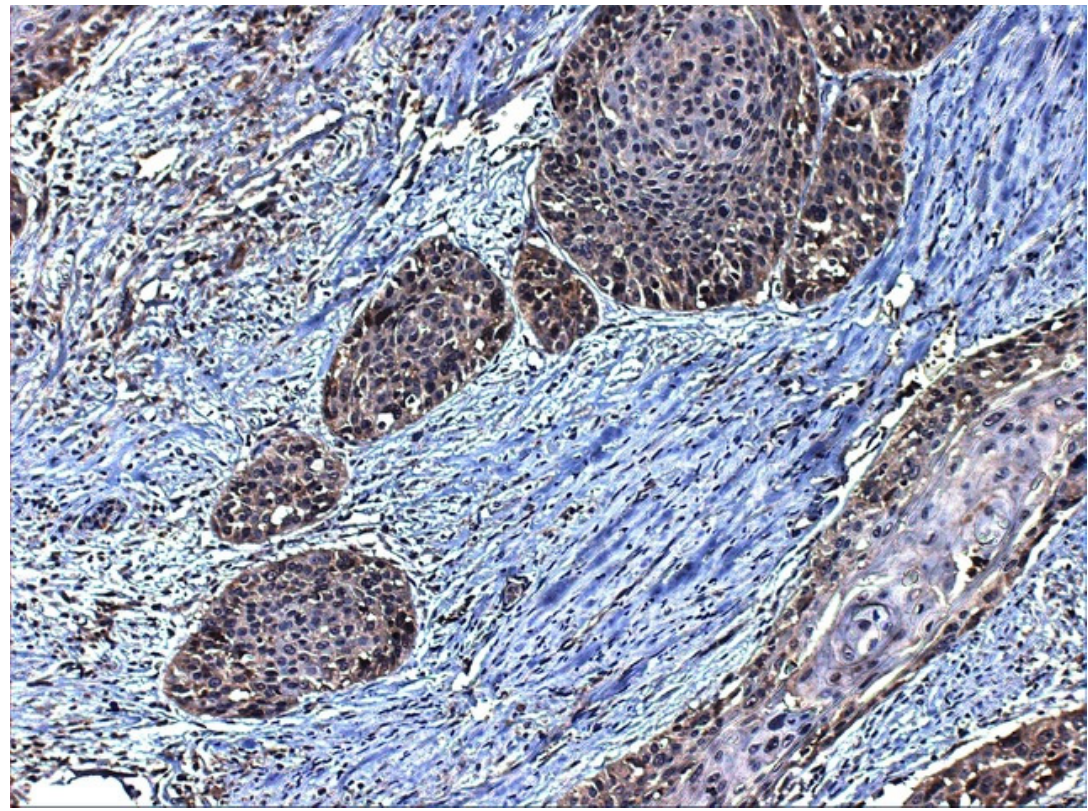
Figure 5. NK1R immunostaining of tumour cells in laryngeal squamous cell carcinoma. NK1R expression was detected mainly in the cytoplasm of the neoplastic cells. Interestingly, also fibroblasts and lymphocytes among the tumour nests displayed NK1R expression.